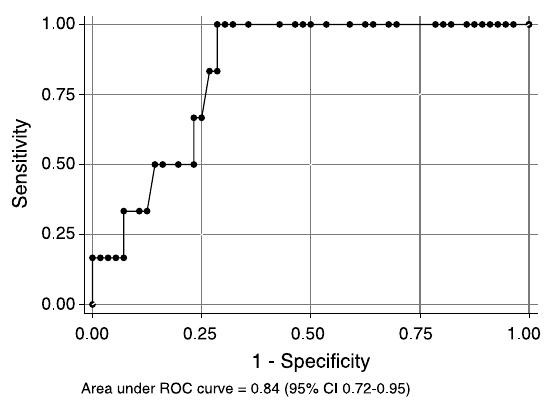
Fig. 3. ROC curve of TRAP assay